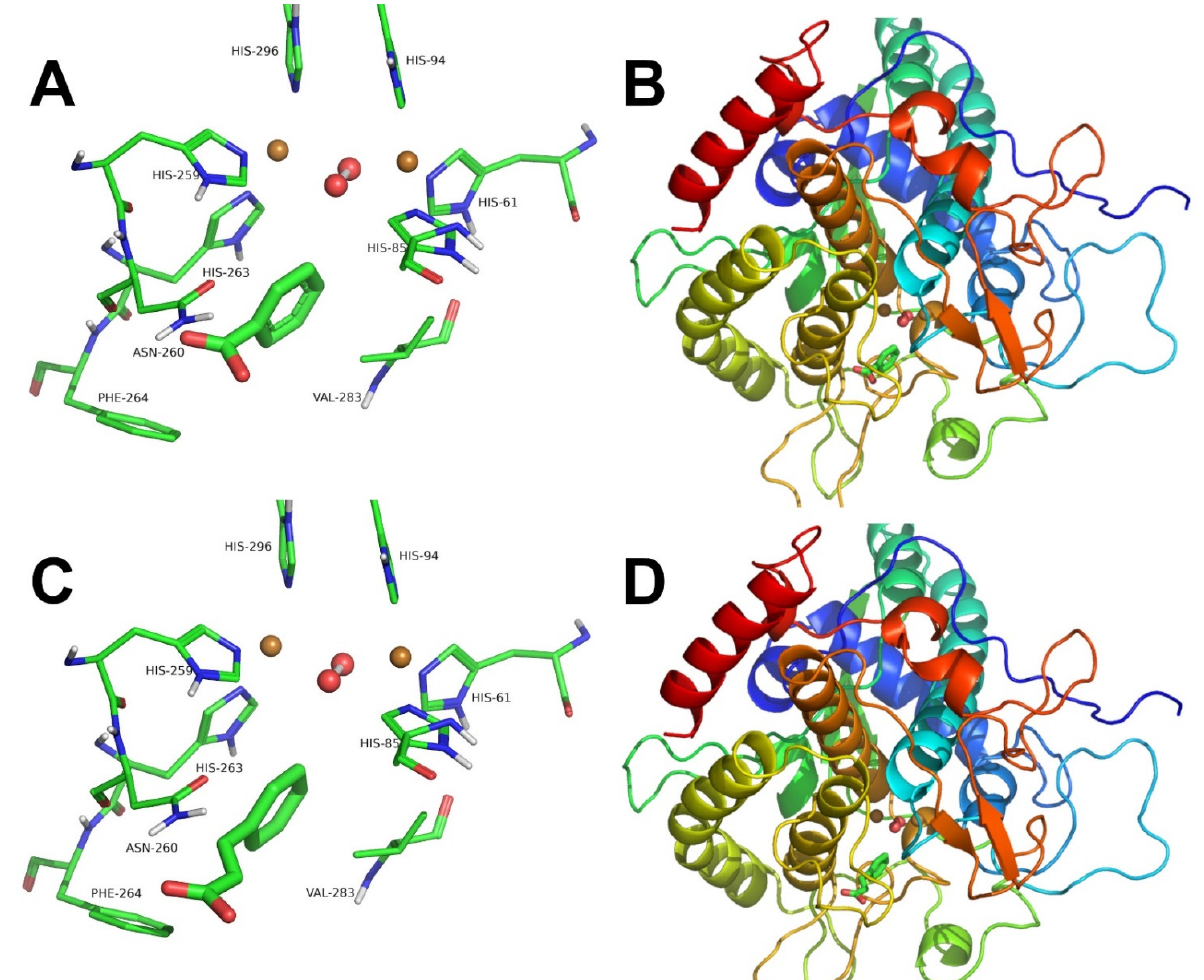
Figure 3. Docking of benzoate ( A , B ) and cinnamate ( C , D ) to oxy -tyrosinase. The binuclear active copper site in thin sticks ( A , C ) and the whole structure of oxy -tyrosinase in ribbons ( B , D ) are depicted with the ligands. The atom colours are as follows: oxygen = red, nitrogen = blue, copper = brown, white = hydrogen, and carbon = green. Ligands are shown in thick sticks and tyrosinase residues in thin sticks.